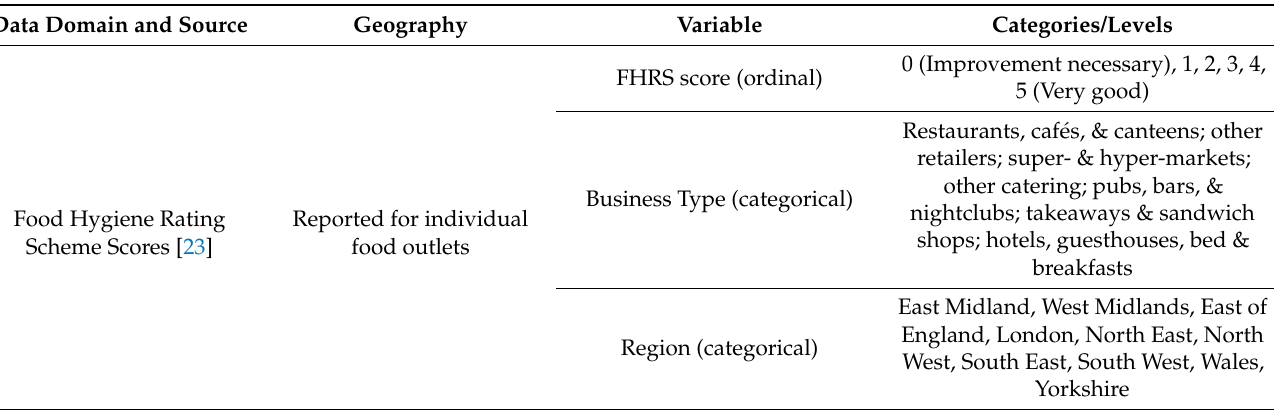
Table 1. Data sources and variables.